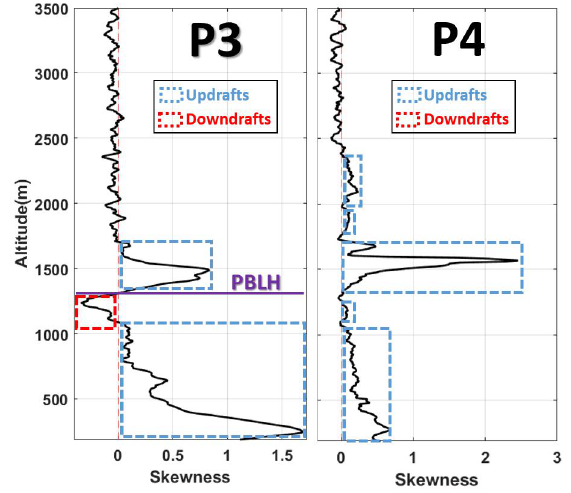
Figure 2: Skewness profile for two periods without clouds, P3 and P4 (fig.1).